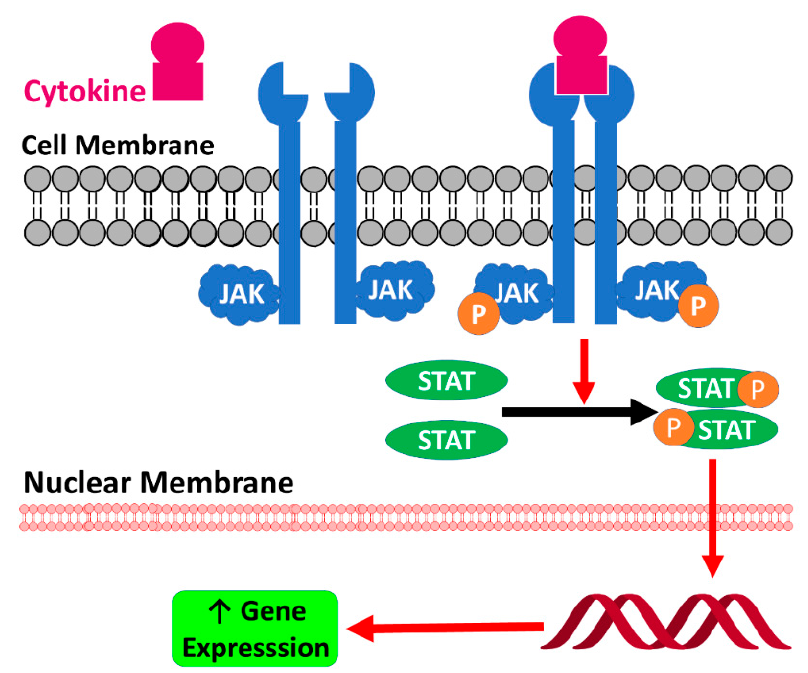
Figure 2. JAK-STAT